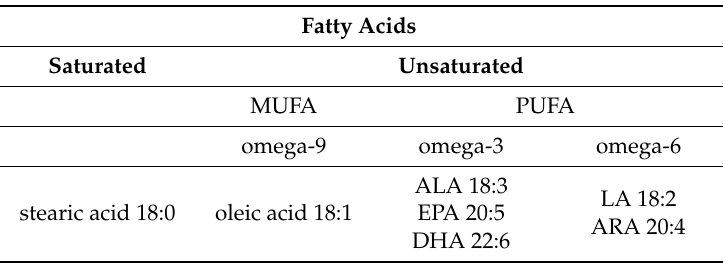
Table 1. Fatty acids’